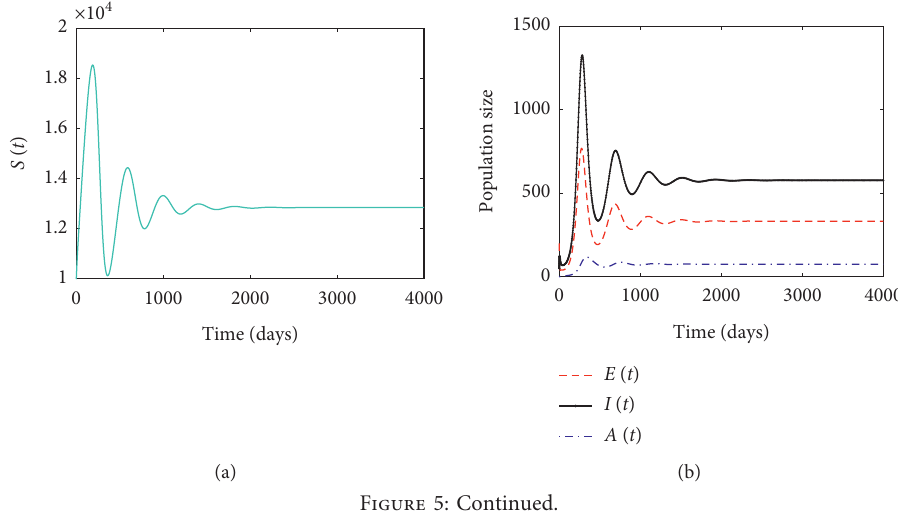
> 1 when the vaccination validity τ is 30 days. 0 � 9 . 0